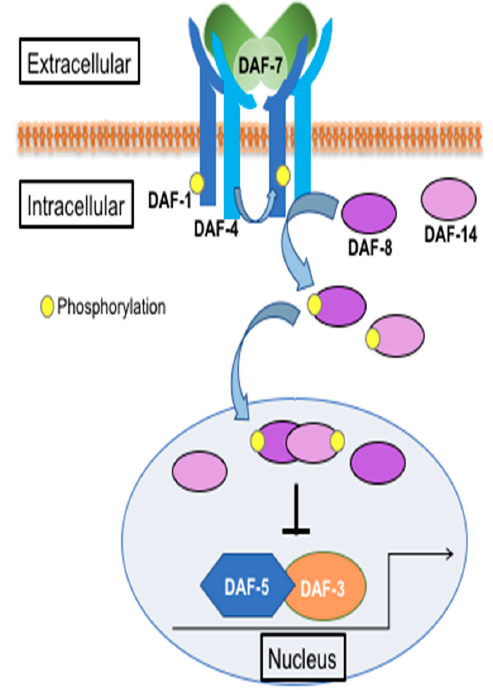
Figure 1. Schematic of the DAF-7 / TGF β pathway in C. elegans. (Adapted from wormbook.org).